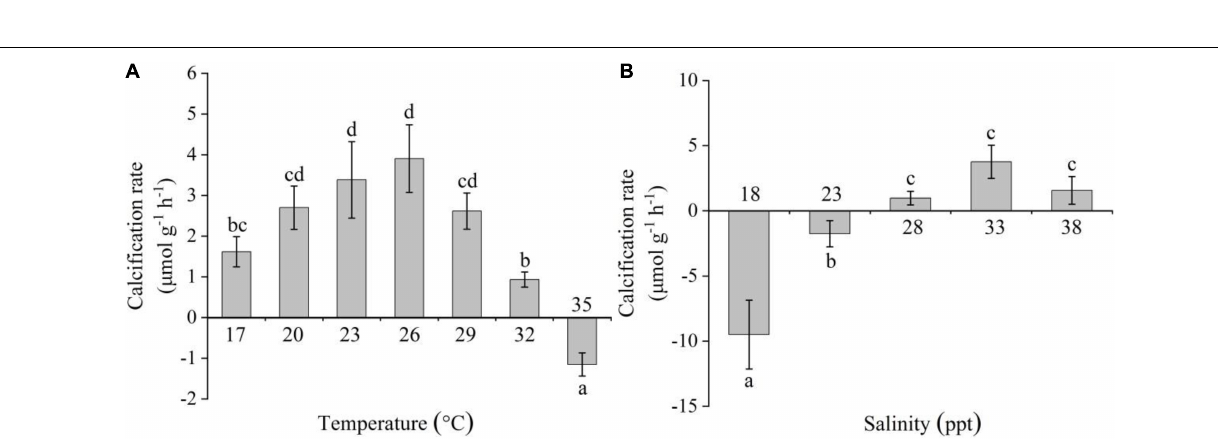
FIGURE 4 | Effects of temperature (A) and salinity (B) on the calcification rate of Creseis acicula . Bars denote standard deviation. Different superscripts indicate significance ( P < 0.05) among the different temperature and salinity treatments, respectively.